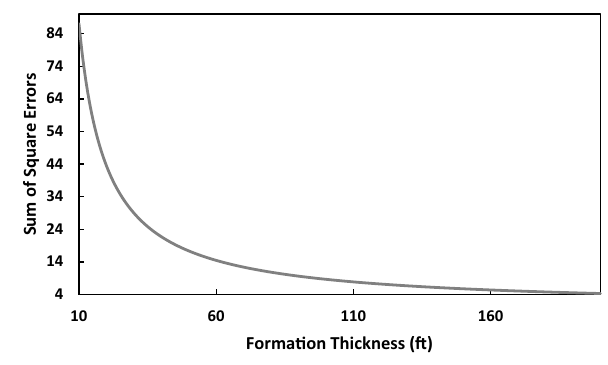
Fig. 10 The impact of formation thickness on the error between pseudo-pressure before and after correction